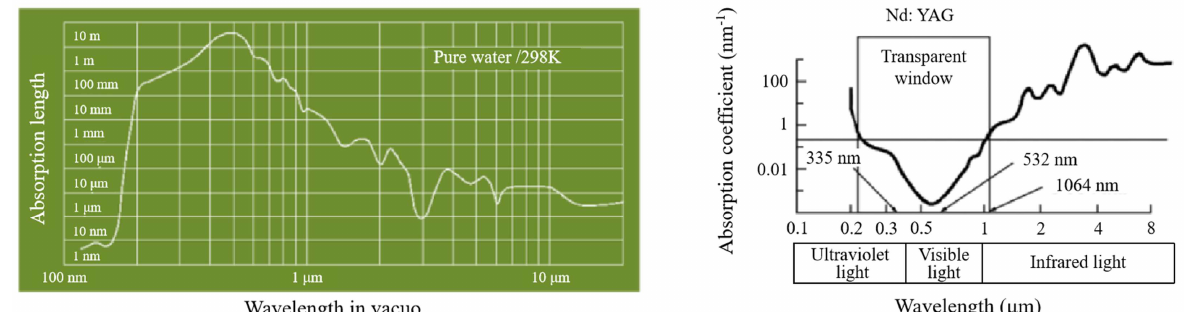
Figure 4. Absorption lengths of pure water to the laser of different wavelengths. When the thickness of the water layer is 80 mm, the laser intensity ( I ) striking the workpiece surface is approximately 90.97% of the initial laser intensity ( I 0 ). The actual coupling efficiency of the laser intensity after passing through the coupling cavity is shown in Figure 5.